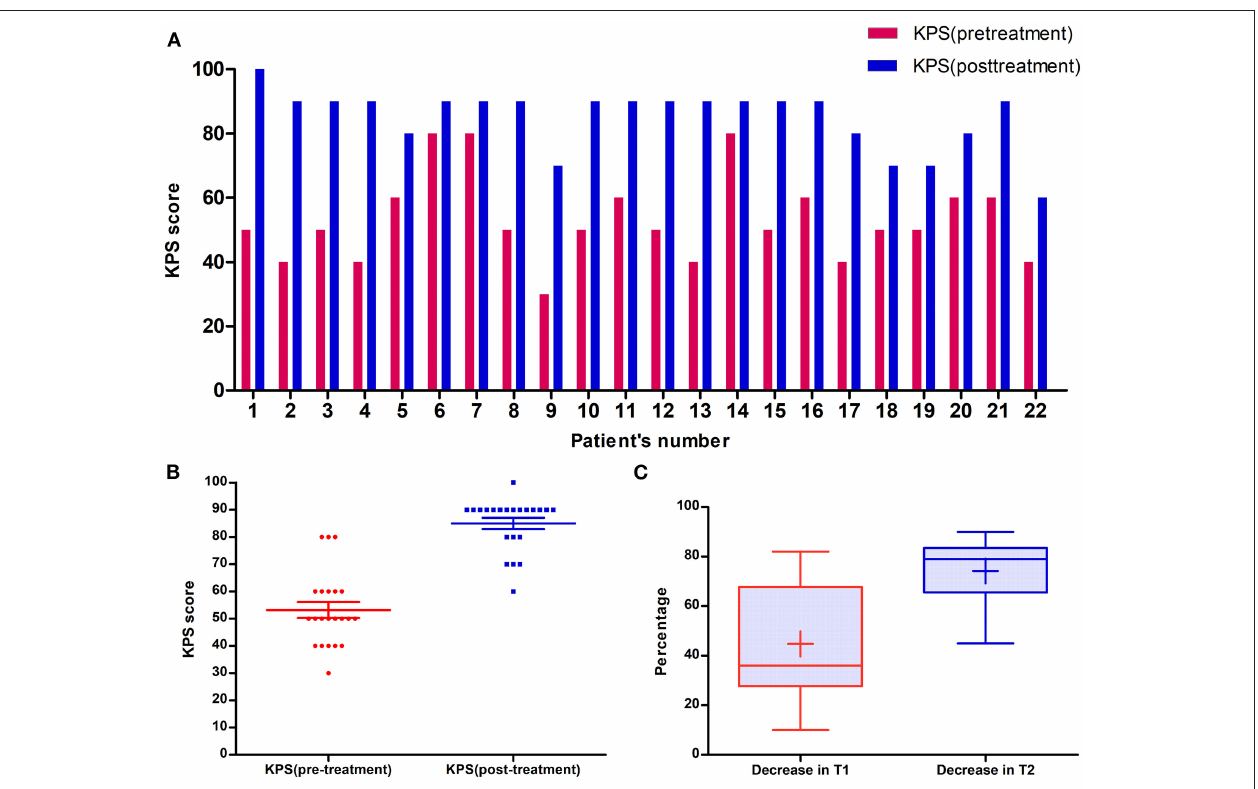
FIGURE 3 | (A) The change of each patient’s KPS score after bevacizumab treatment. (B) Scatter plot of KPS scores of patients in cohort before and after bevacizumab treatment: the median KPS score of patients before bevacizumab treatment was 50, however, median KPS score increased to 90 after bevacizumab treatment. (C) Boxplot of imageology of patients in cohort before and after bevacizumab treatment. After bevacizumab treatment, the volume of nidus in Gadolinium and T2 sequence decreased by 44.7 and 74.2%,